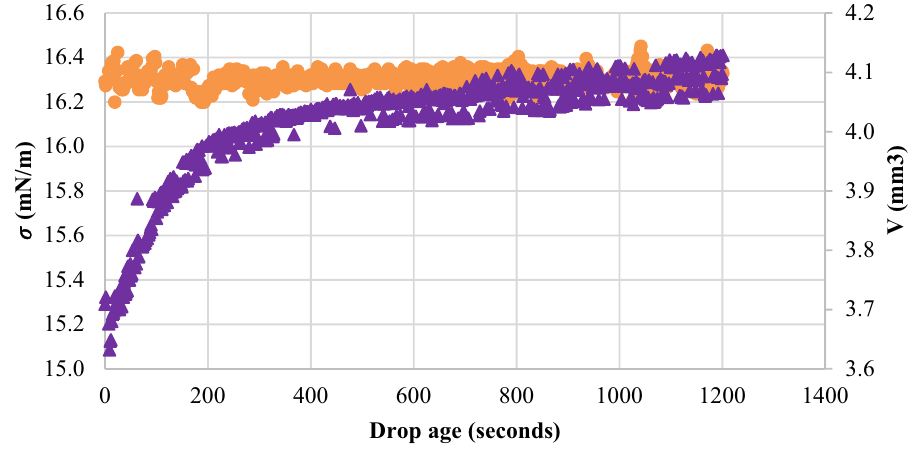
2 O in CO 2 as a function of pressure at 30 °C and 50 °C. The figure also shows the drop vol- Dynamic interfacial tension The dynamic interfacial tension (time dependent) and the drop volume of TEG–CO are shown on the left- and 2 right-hand sides of Fig. 9, respectively. IFT of TEG–CO 2